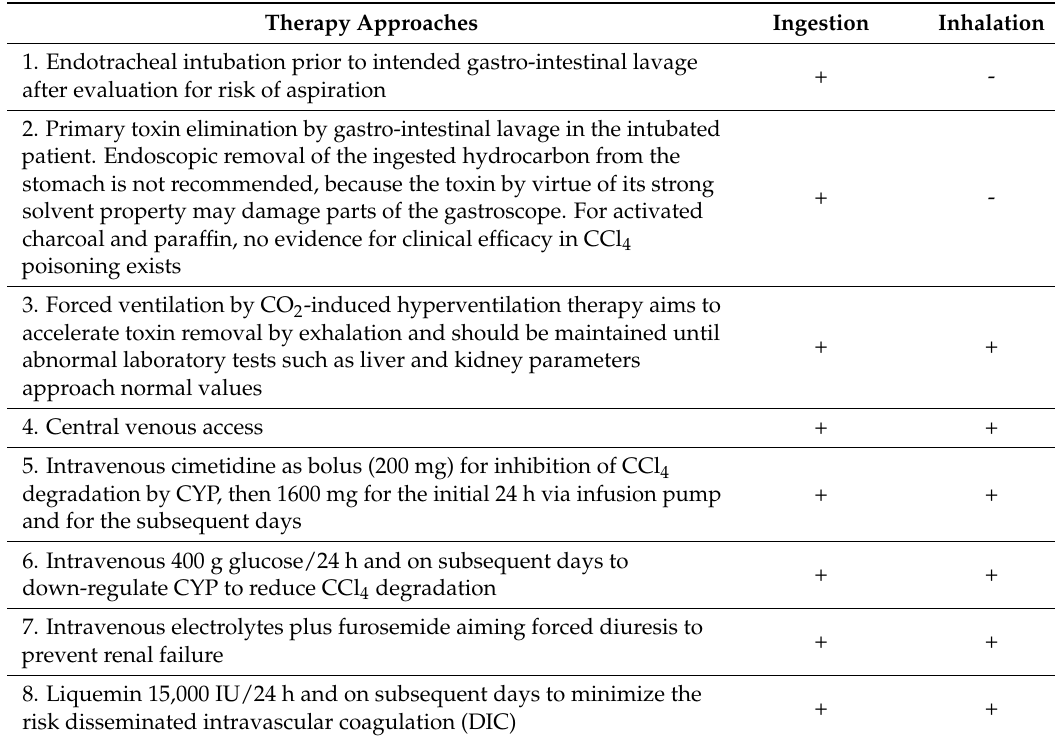
Table 4. Therapy of adult patients with acute CCl 4